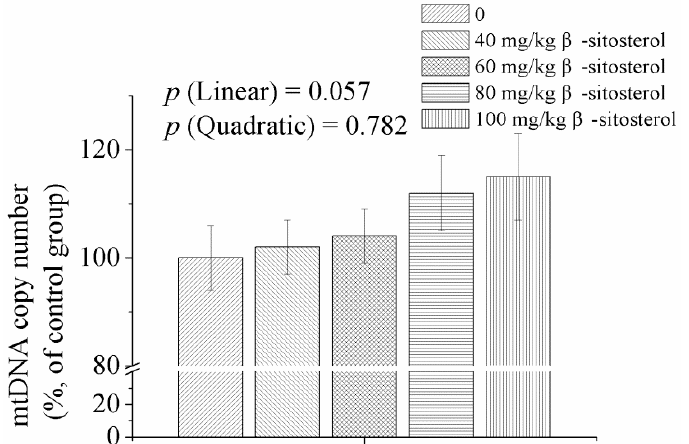
Figure 1. Effect of dietary β -sitosterol supplementation at different levels on genes expressions related to mitochondrial biogenesis of breast muscle in broilers. mtDNA, mitochondrial DNA. Data are shown as means and standard errors ( n = 6).